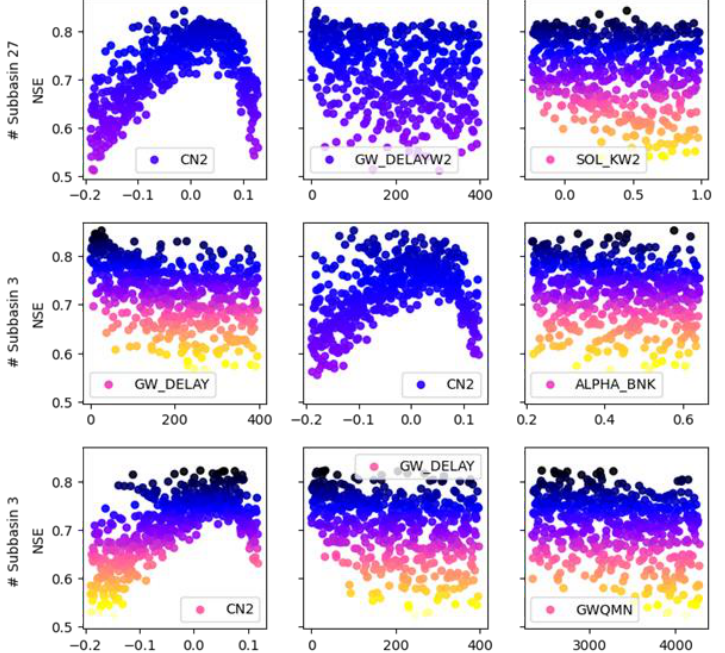
Figure 7. Dotty plots of the coefficient of NSE against SWAT parameters (left columns represent the most sensitive) using SUFI2 based on 500 samples from the Wabi watershed. (Note that # Subbasins 27, 3, and 3 account for 2%, 10%, and 20% of the Wabi watershed area, respectively.).